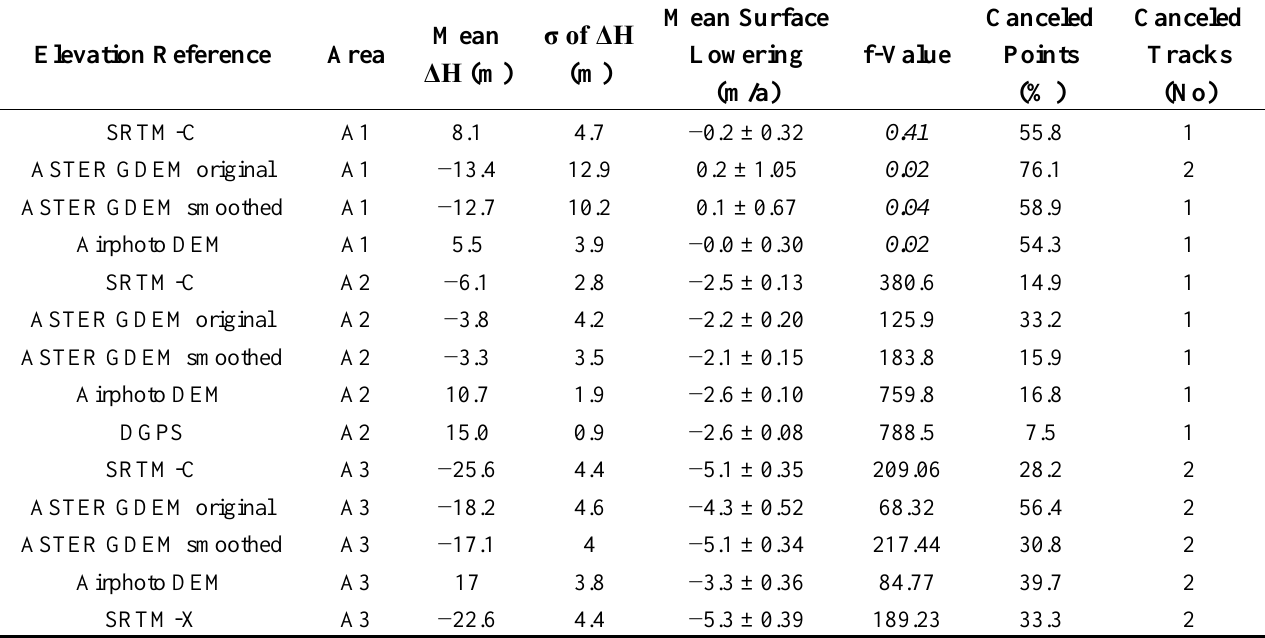
Table 2. Mean surface lowering for areas A1, A2 and A3 using different DEMs as elevation reference. The snow pack correction and the threshold of the terrain slope were applied. F-values in italics indicate a statistically non-significant trend.